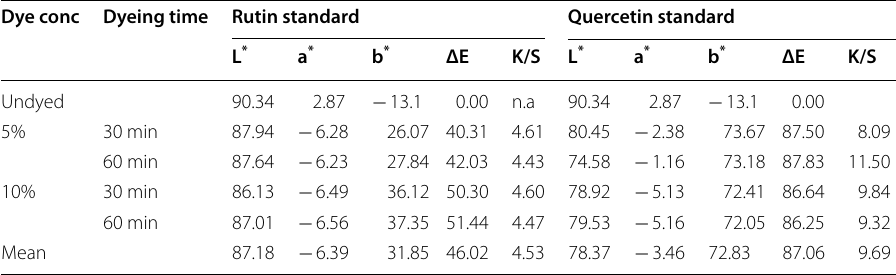
Table 7 Color values and color strength values of cotton dyed with Rutin and Quercetin standards Dye conc Dyeing time Rutin standard